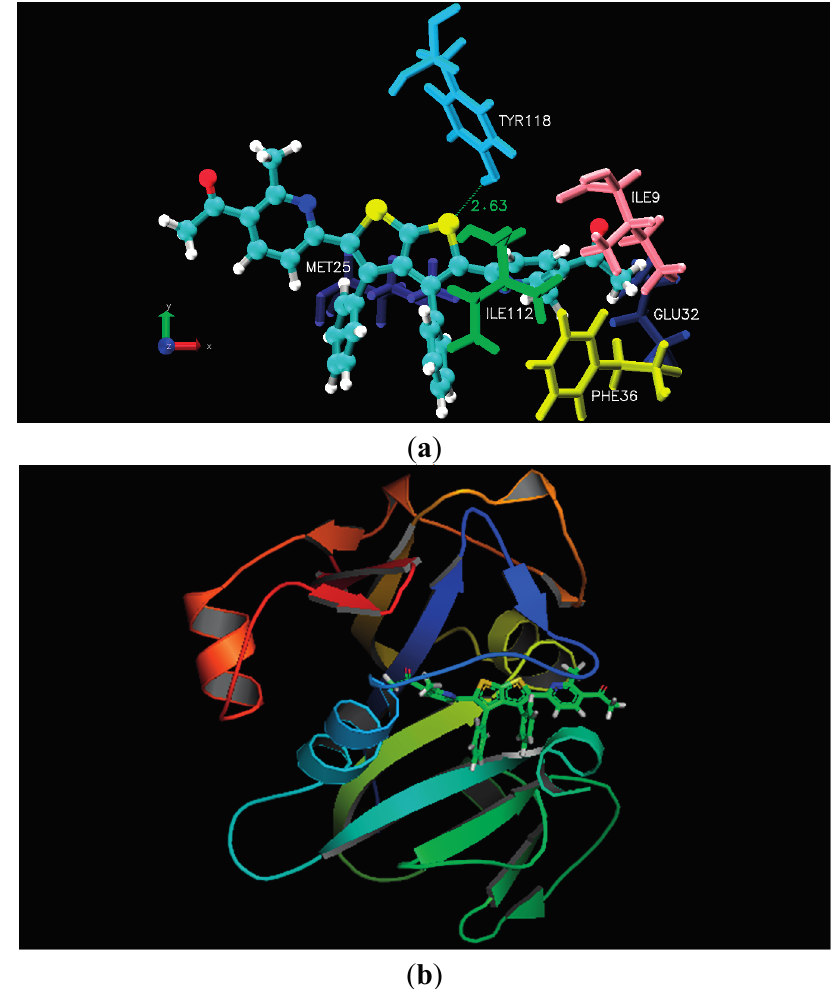
Figure 1. ( a ) Molecular docking interaction model for the most potent anti-fungal compound 4a with C. albicans dihydrofolate reductase protein (PDB ID.4HOF) showing hydrogen bonding, hydrophobic and Van der Waals interactions; ( b ) ribbon diagram of dihydrofolate reductase ( C. albicans ) complex with inhibitor 4a